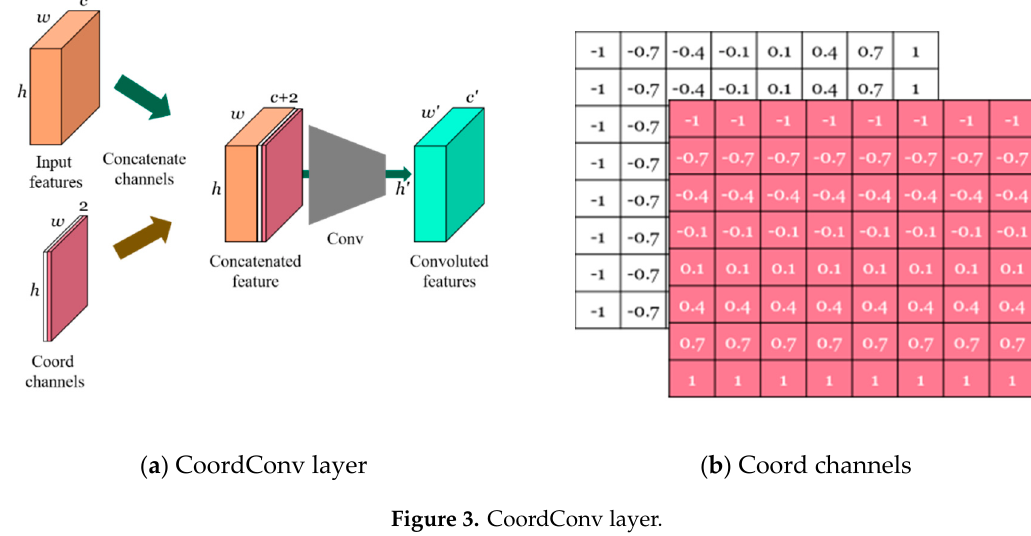
Figure 3. CoordConv layer.